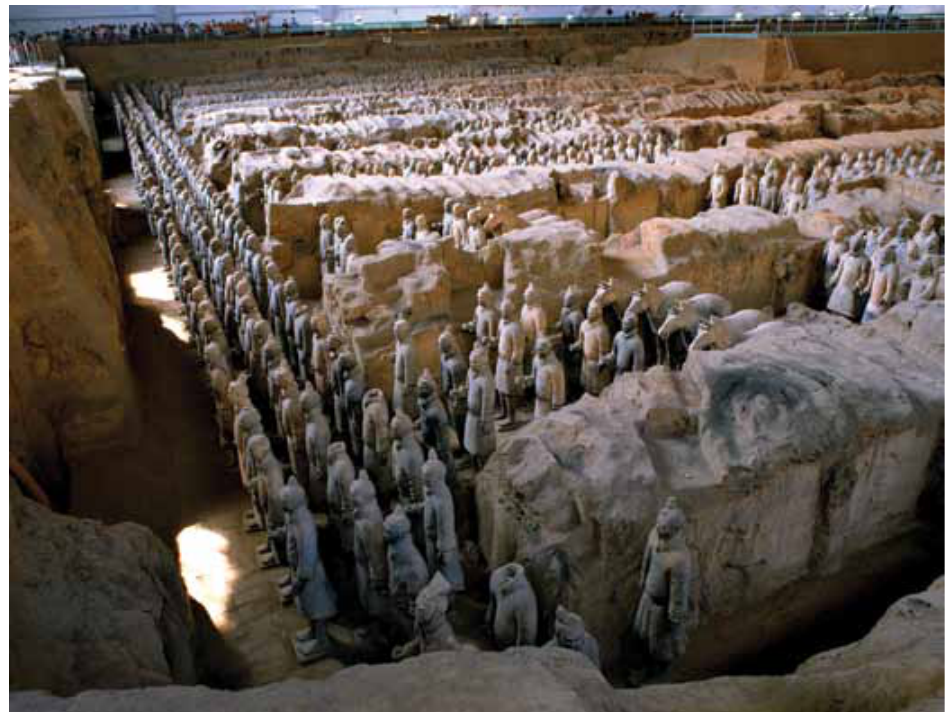
Fig. 2: Overview of some warriors in Pit 1 of the Terracotta Army (photo: Xia Juxian).